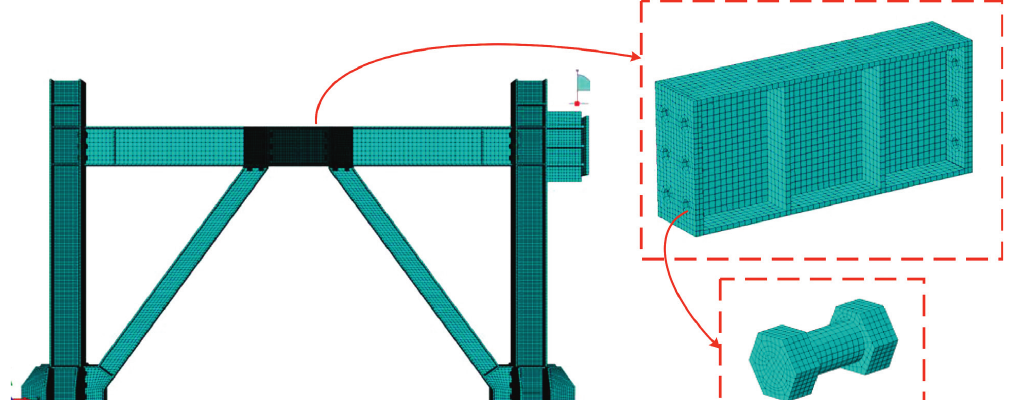
Figure 30: FEA model.